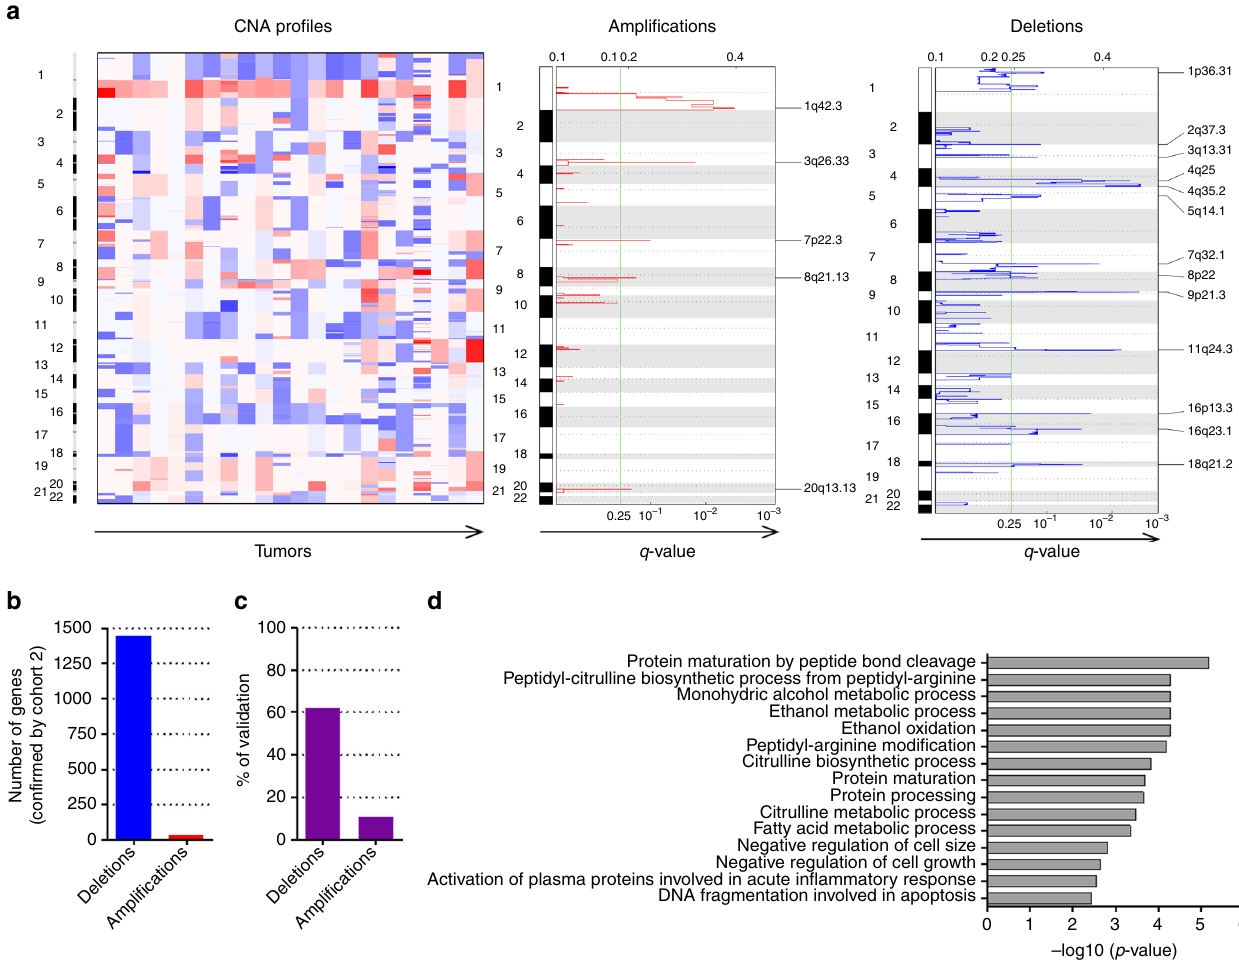
Fig. 3 ACC are characterized by numerous copy number alterations, mainly deletions. a CNA pro fi les: heatmap of copy numbers calculated via the intensities of the 450K array (each tumor versus average normal) are displayed for each tumor of cohort 1 and each chromosome (red: ampli fi cations, blue: deletions). Ampli fi cations: q values of ampli fi cations of all tumors of cohort 1. Deletions: q values of deletions of all tumors of cohort 1. b Con fi rmed number of genes mapping to signi fi cantly ampli fi ed or deleted regions. c Percentage of genes signi fi cantly ampli fi ed or deleted of cohort 1 that were con fi rmed in cohort 2. d GO enrichment analysis displaying enriched pathways of ampli fi ed and deleted genes (input: regions of cohort 1 con fi rmed in cohort